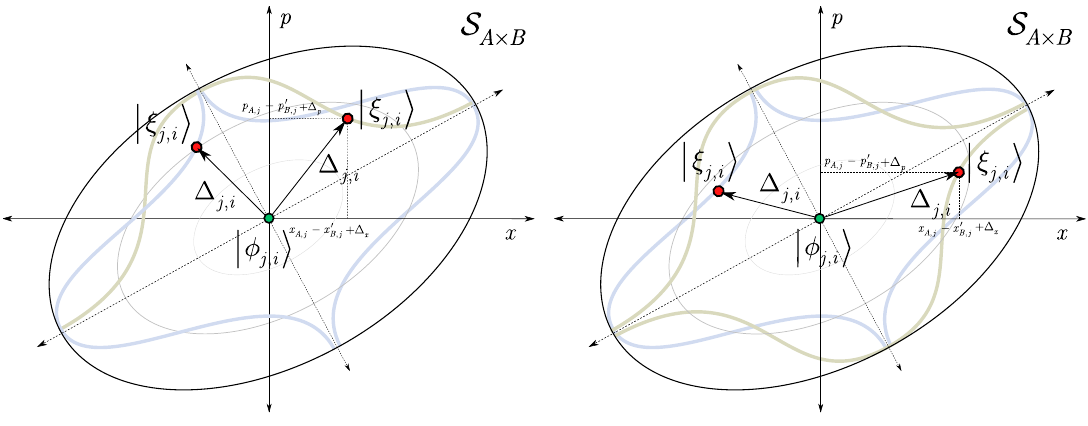
Figure 4. The real Gaussian noise of the quantum channel N 2 causes a rotation and rescaled vector in the combined phase space S A × B ( x : position quadrature, p : momentum quadrature). The magnitude (cid:107) ∆ (cid:107) of the noise vector ∆ ∈ N 0, σ 2 N is not preserved, since the noise characteristic describes an ellipse in the combined phase space.